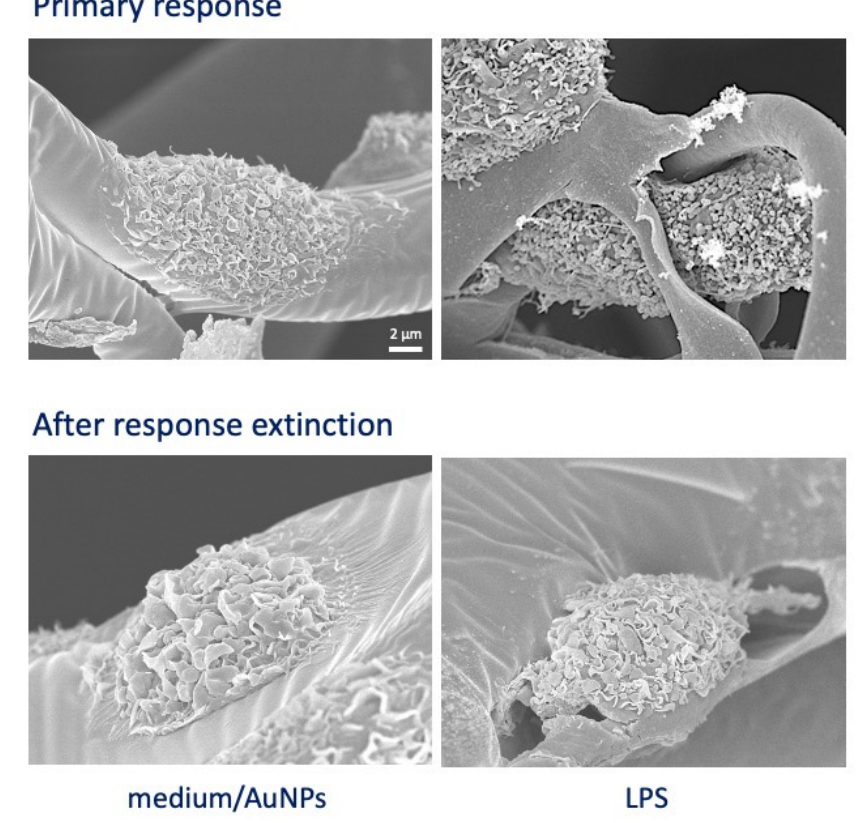
Figure 2. SEM images of monocytes in 3D culture. Upper panels: monocytes exposed for 24 h to culture medium alone or containing AuNPs (showing identical morphology; ( left )) or LPS ( right ). Lower panels: monocytes primed with either culture medium alone or containing AuNPs ( left ) or LPS ( right ) observed after 6 days of resting in the absence of